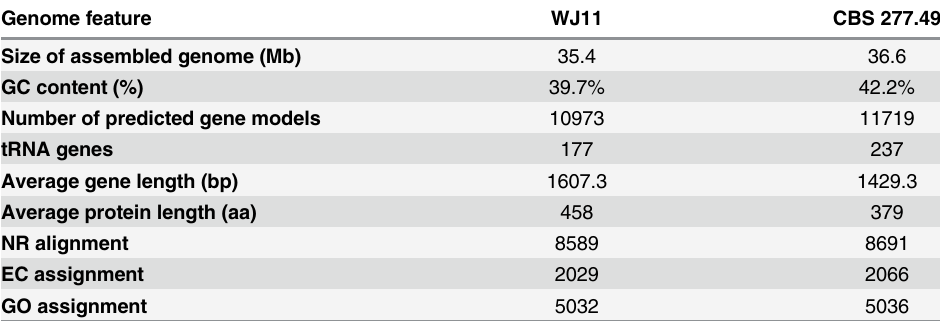
Table 1. Characteristics of the gonomes of M . circinelloides WJ11 and CBS 277.49. Genome feature